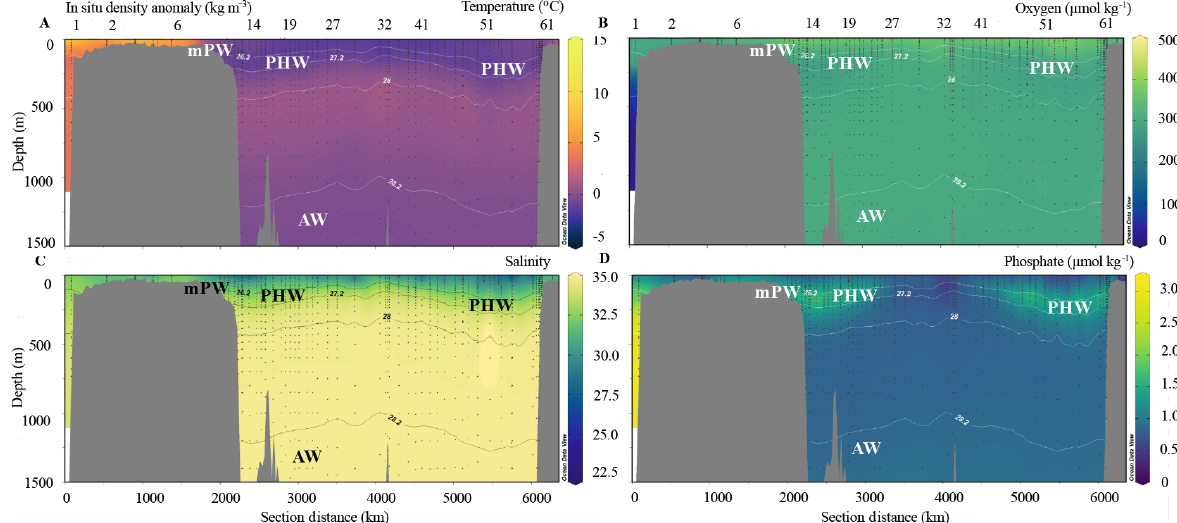
Figure 2. In situ temperature (a) , nitrate (b) , salinity (c) , phosphate (d) , oxygen (e) , and silicate (f) with neutral density anomaly contours from the northern and southern legs of the GN01 transect as shown in Fig. 1. Major water masses are labeled as modified Pacific water (mPW), Pacific halocline water (PHW), and Atlantic water (AW).